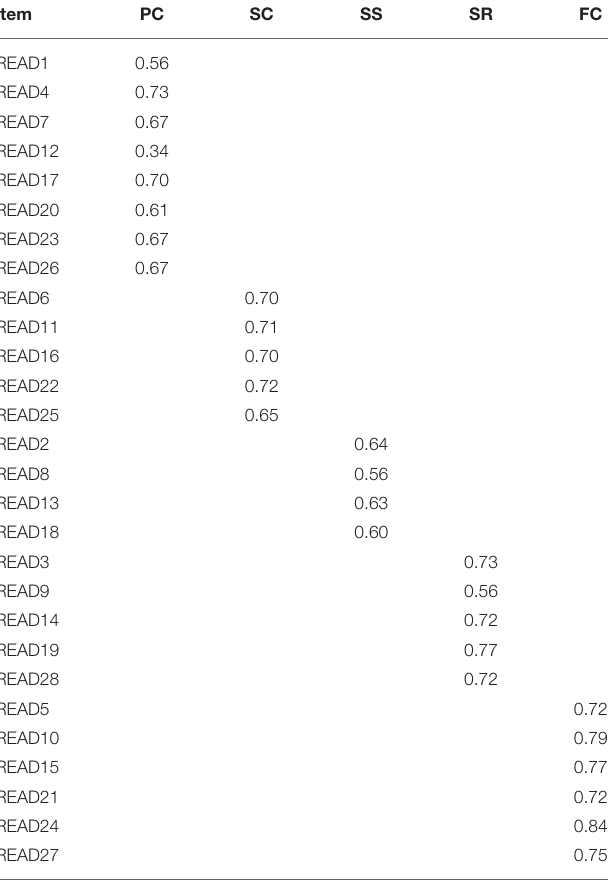
TABLE 2 | Factor structure of the Resilience Scale for Adolescents (READ; N =